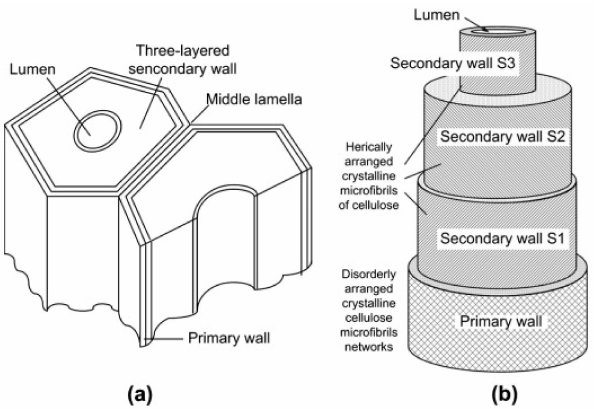
Figure 3. Structure of natural fibers ( a ) cell wall ( b ) structural components. Reprinted with permission from Ref. [45]. License Number: 5413150388892.